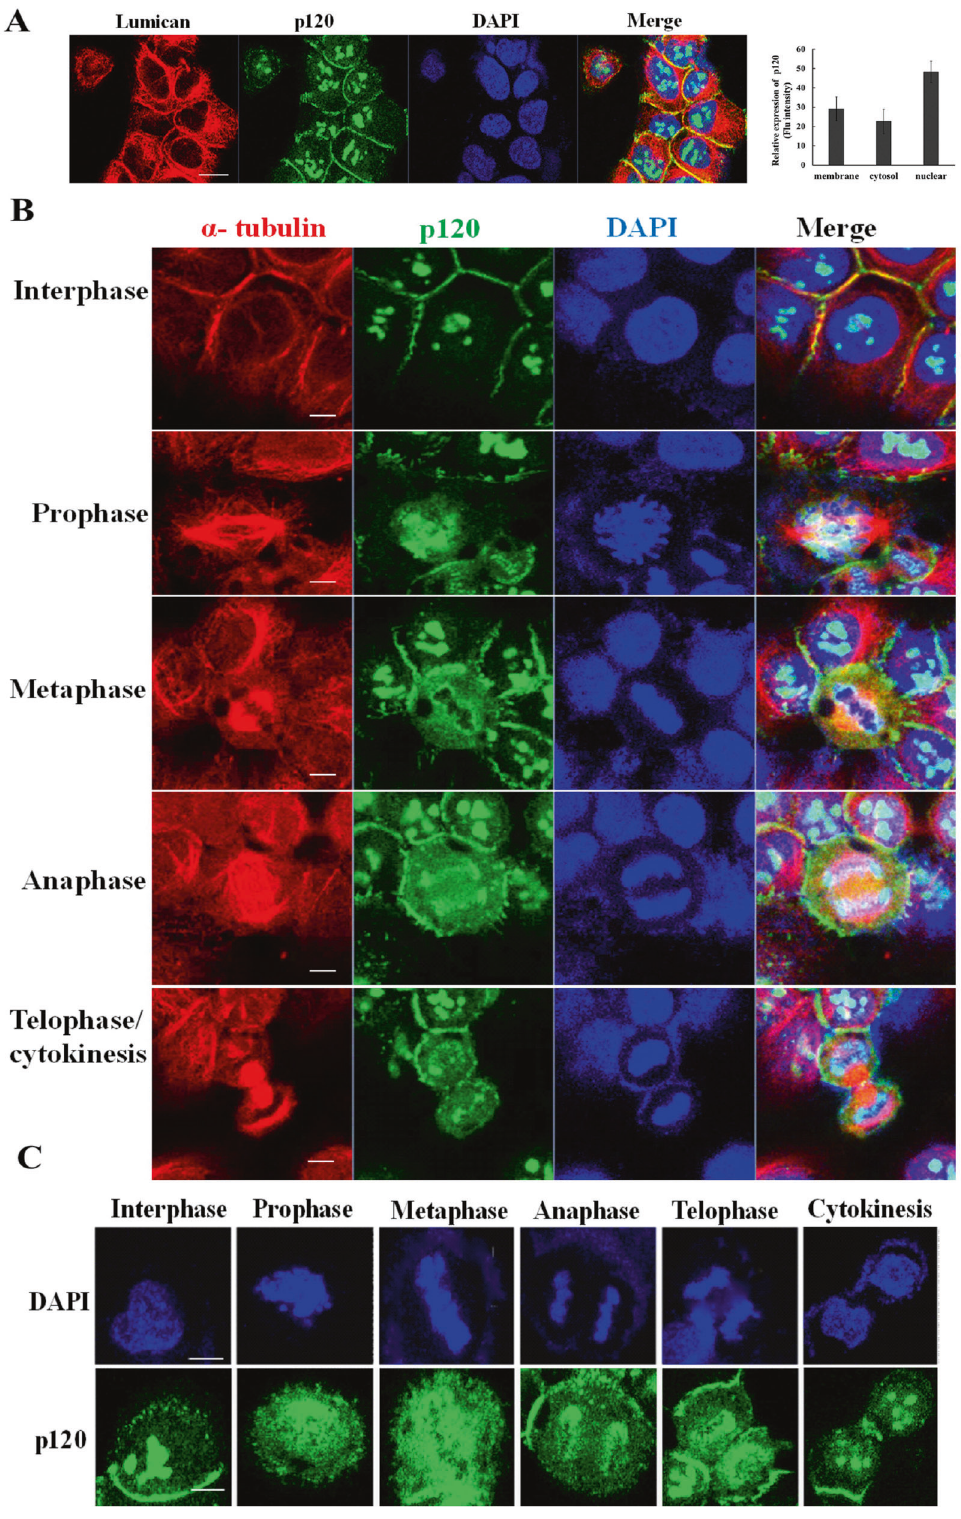
Fig. 2 Dynamic morphology of p120 catenin during the processes of cell division. A Subcellular distribution of p120 catenin in lung cancer cells. H460 cells were fi xed and immunostained using anti-p120 catenin (green) and anti-lumican (red) antibodies. Cell nuclei were visualized by DAPI staining (blue). The arrows indicate the interactions of p120 catenin and lumican at the juxta-membrane region. The relative fl uorescence intensity of p120 catenin (green) was quanti fi ed using Image J. Scale bar, 20 µm. B Distribution and morphology of p120 catenin during cell division. Cells were immunostained using anti-p120 catenin (green) and anti- α -tubulin antibodies (red). DNA was stained with DAPI (blue). Confocal images of cells in interphase, prophase, metaphase, and telophase (cytokinesis) are shown. C Dynamic changes in the distribution of p120 catenin were observed during the mitotic